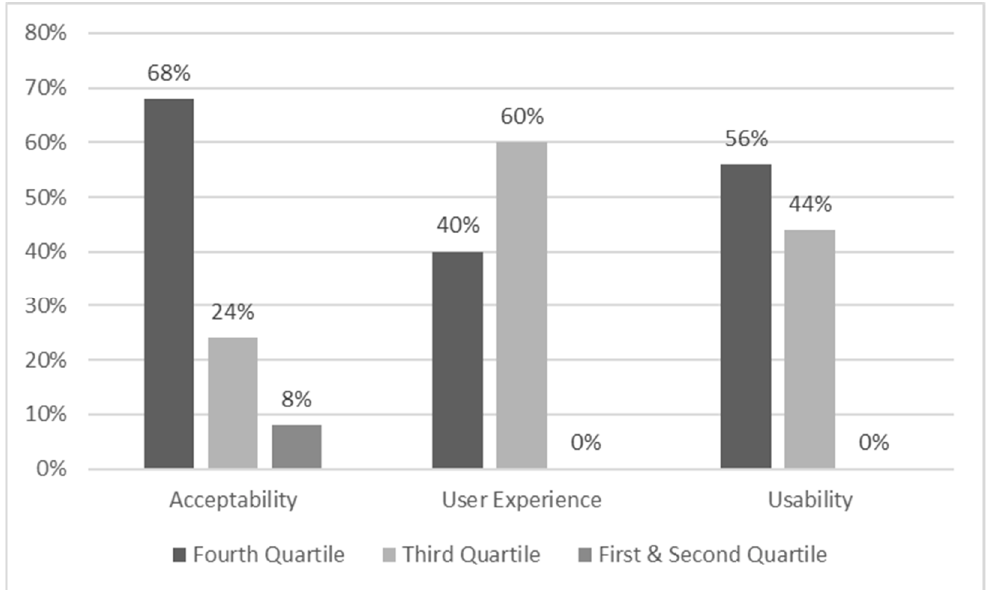
Figure 9. Percentages of the responses per score quartile; quartiles were defined by the maximum possible score of each questionnaire divided by four. Fourth quartile = highest possible scores; first quartile = lowest possible scores.